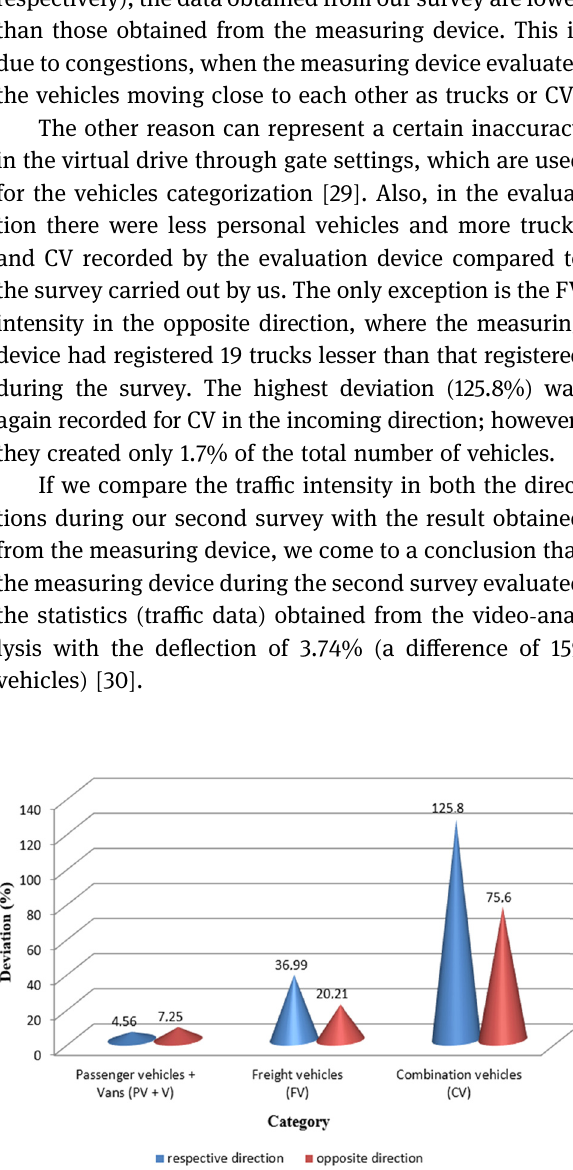
Figure 7: The ratio of the individual vehicles categories ( 2nd survey )